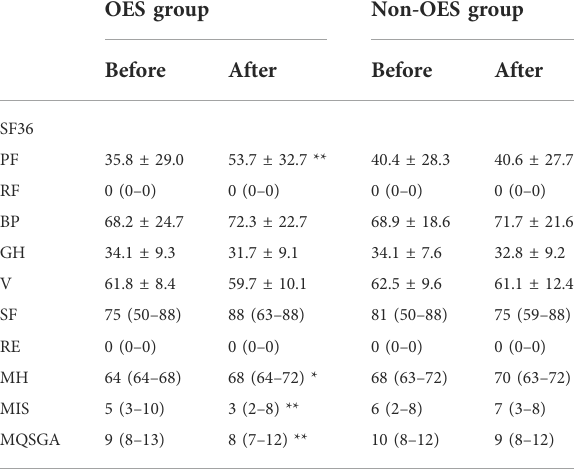
TABLE 3 Change in SF36, MQSGA, and MIS between the two groups. OES group Non-OES group After Before